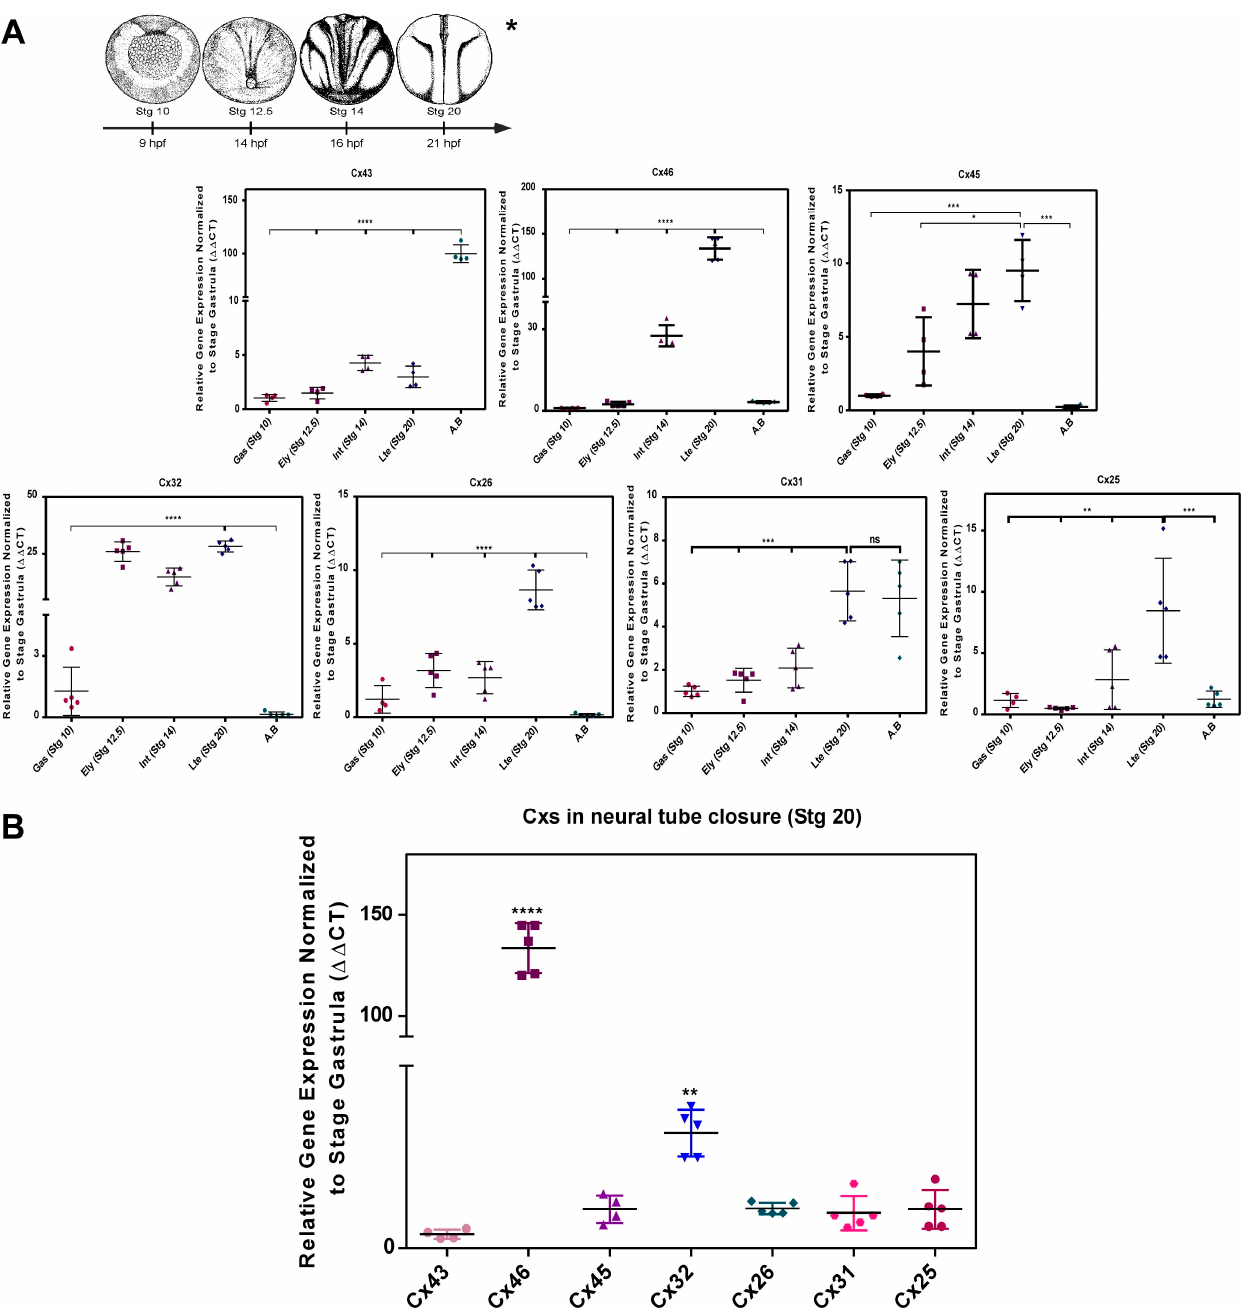
Figure 1. Cx46 and Cx32 transcripts are enriched during Xenopus laevis Neurulation. ( A ). RT-qPCR of Cx43, Cx46, Cx45, Cx32, Cx26, Cx31, and Cx25 in the process of formation of the neural tube of Xenopus laevis N = 4. ( B ). Comparative analysis of expression of Cxs in the closure of the neural tube of Xenopus laevis N = 4. Transcriptional expression was normalized to the sub-1 control gene. One-way ANOVA, Dunnett’s correction, (* = p < 0.05; ** = p < 0.01; *** = p < 0.001; **** = p < 0.0001; ns = not significant). The error bars of the data correspond to the standard deviation.